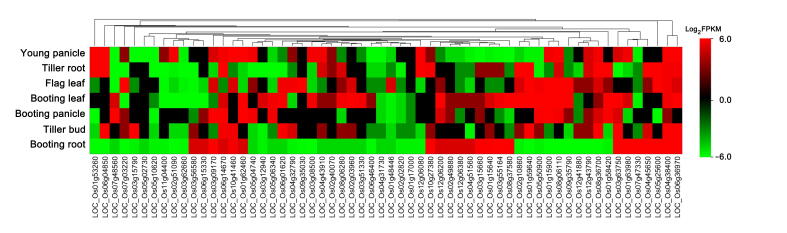
Transcription factors in the key module analyzed by dynamic cross-tissue analysis and their expression in seven tissues.